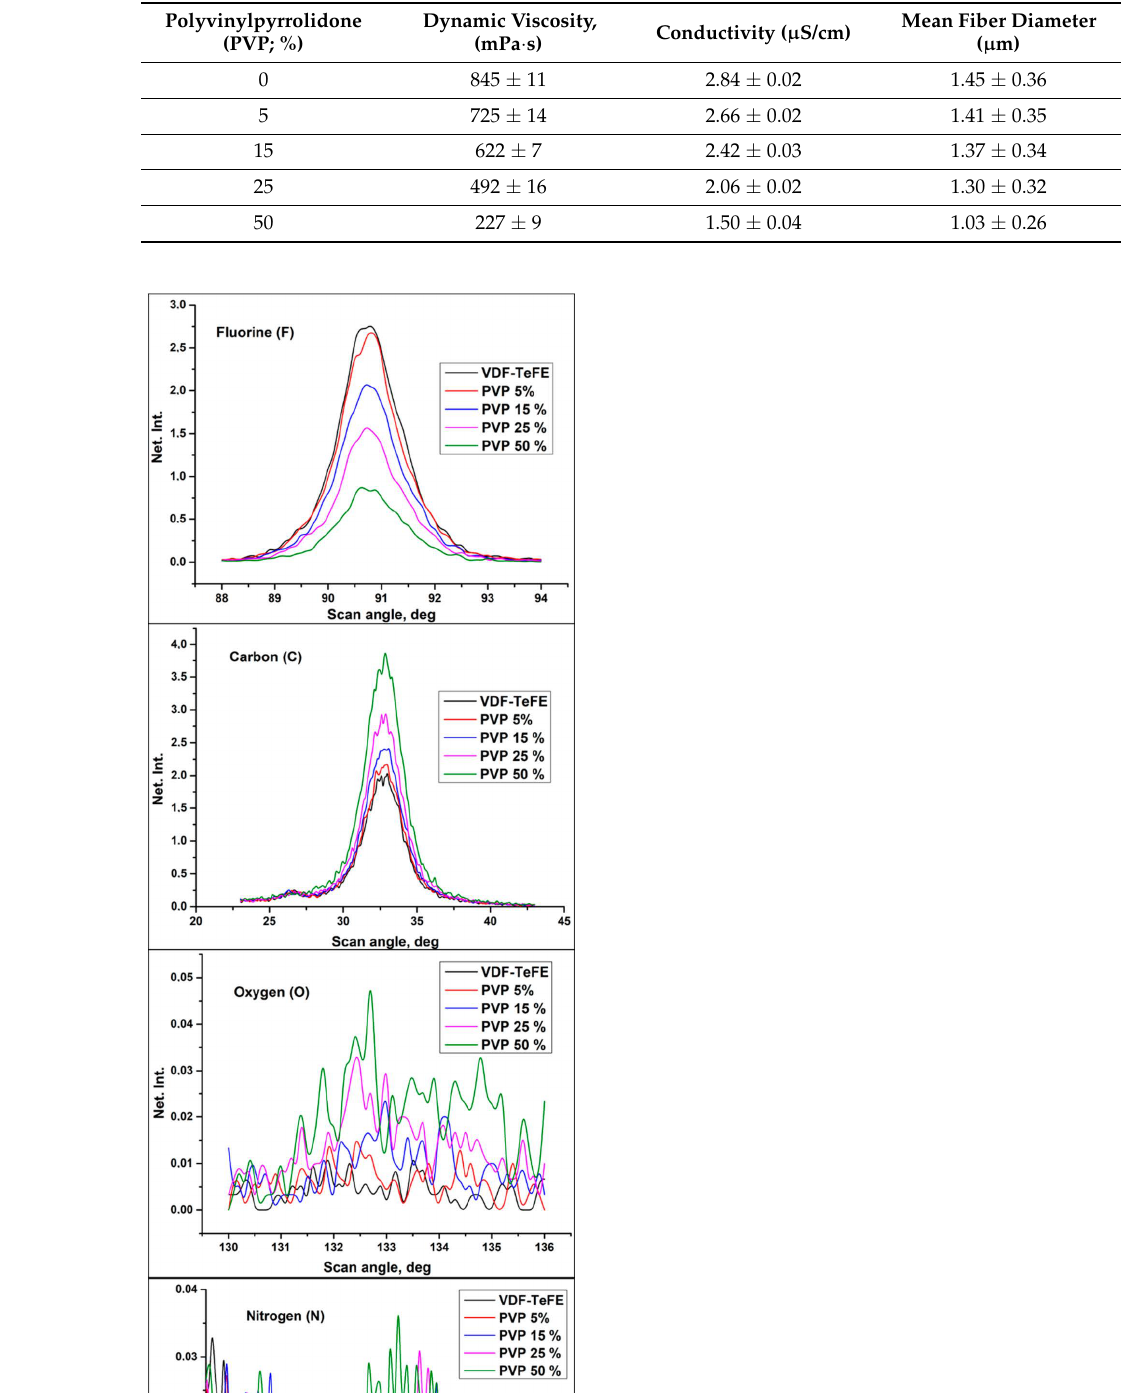
Table 1. Dynamic viscosity values, conductivity values of spinning solutions, and mean fiber diameters in the formed membranes.